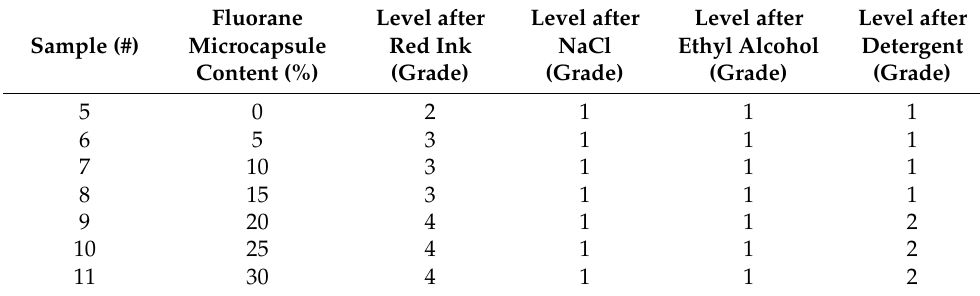
Table 9. The resistance to liquid level of the topcoat with fluorane